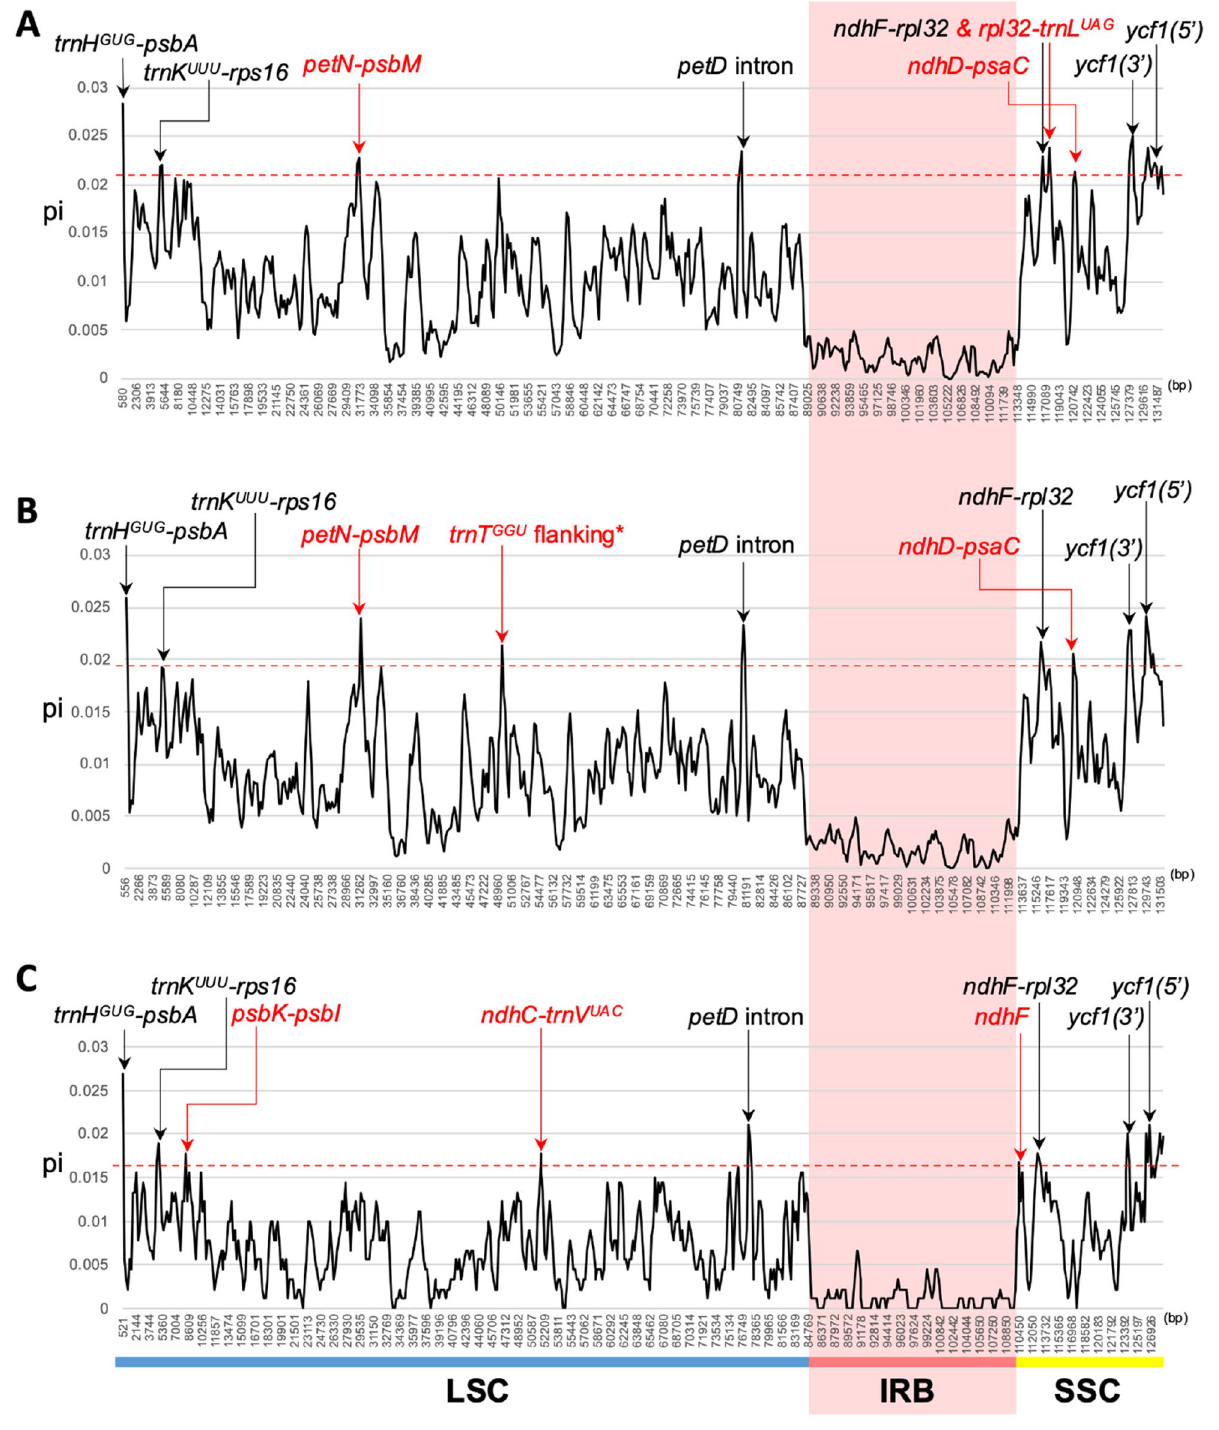
Figure 6. The nucleotide diversity among 19 Primulina and three Petrocodon plastomes. ( A ) The sliding window analysis across the alignment of 19 Primulina + three Petrocodon accessions. ( B ) The sliding window analysis across the alignment of 19 Primulina plastomes. ( C ) The sliding window analysis across the alignment of three Petrocodon plastomes. The red dashed line indicates the lowest pi value of 95th percentile windows in the specific alignment. Regions whose pi values are higher than the red dashed line were marked as variable regions. Names of the variable regions colored in black indicate that they are universal to three alignments, while those colored in red indicate they were identified only in one or two of the alignment(s). *The flanking regions of trnT-GGU